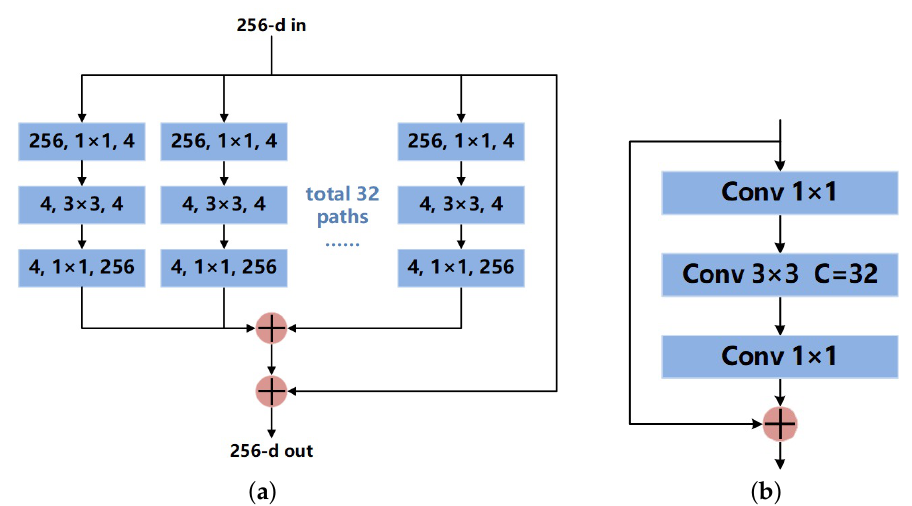
Figure 3. Residual block structure of ResNeXt50: ( a ) theoretical structure; ( b ) practical